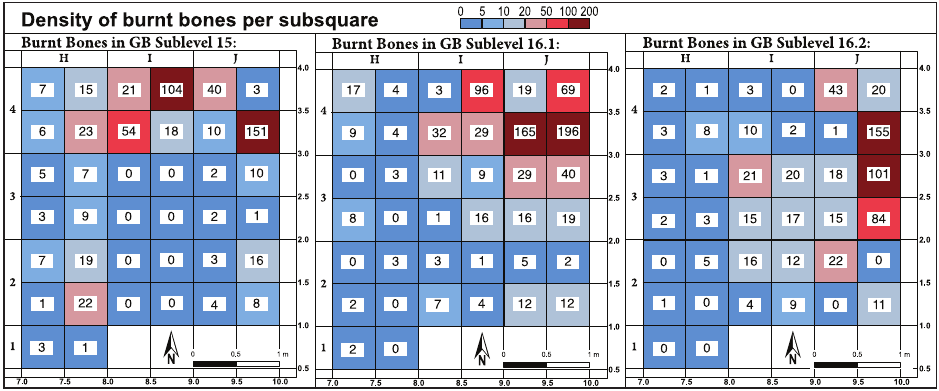
Figure 5: The small refuse burnt bone distribution varies between sublevels 15, 16.1 and 16.2. Amounts of burnt bone remains constant in the northeastern edge of the excavation areas (square J4), which may be associated with a